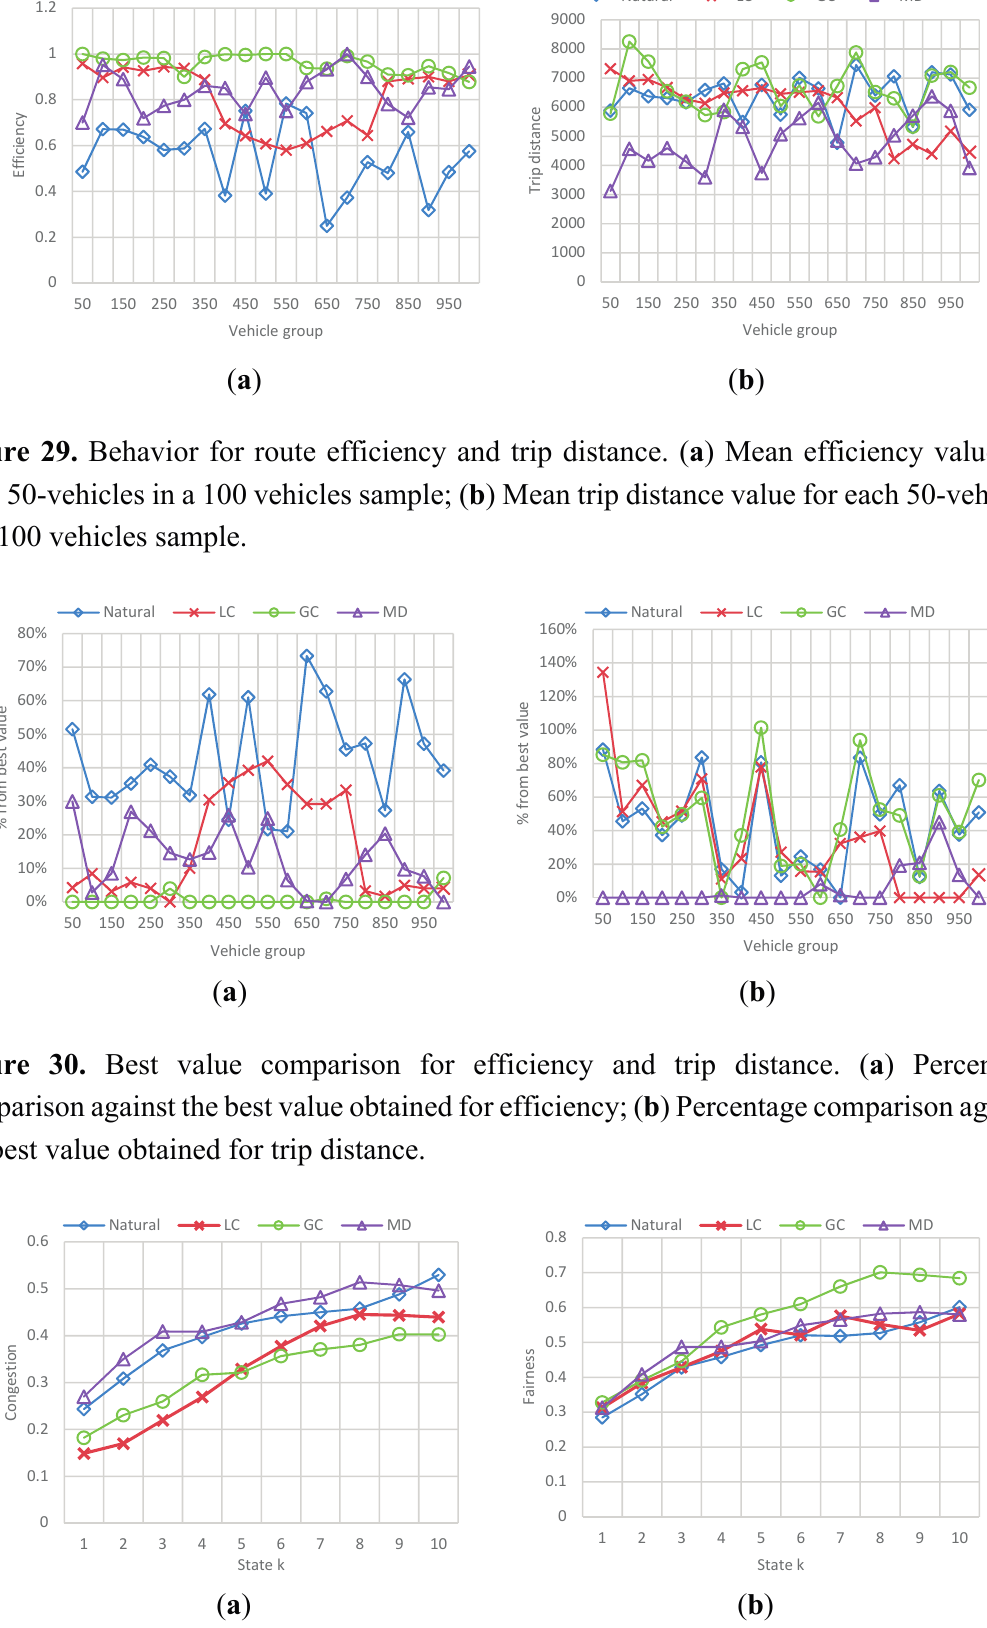
Figure 31. Behavior for Fairness and Congestion. ( a ) Fairness obtained in a state k; ( b ) Avg. congestion obtained in a state